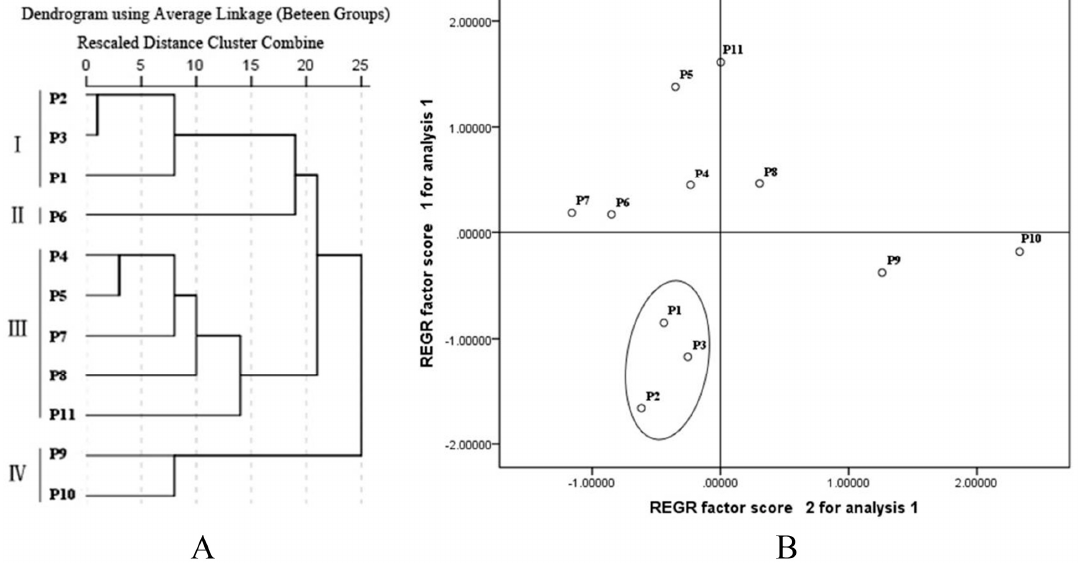
Figure 3. Results of hierarchical cluster analysis and principal component analysis of the samples from 11 provinces. ( A : hierarchical cluster analysis; B : principal component analysis).